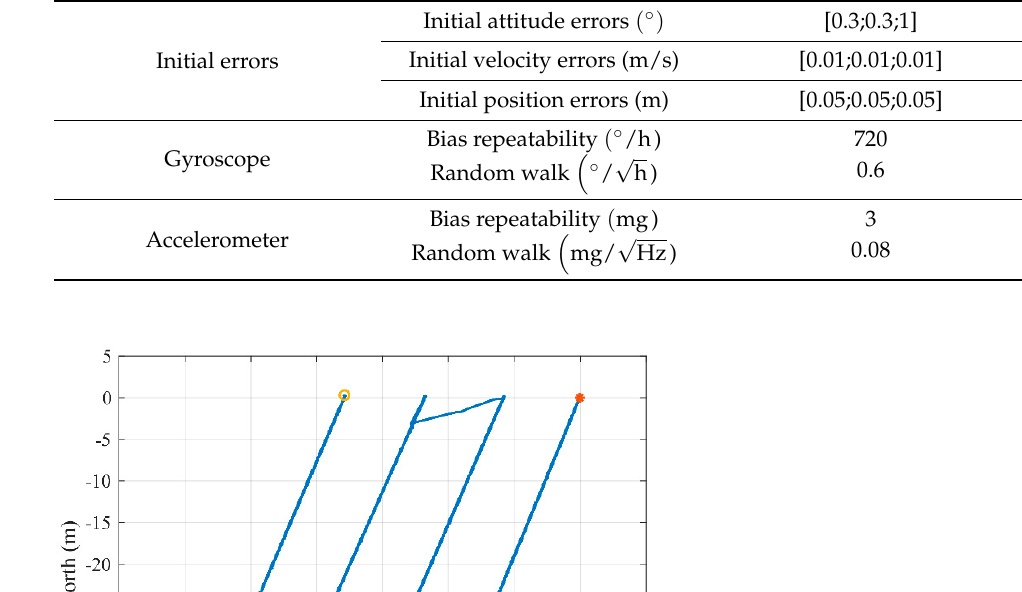
Figure 6. Trajectory of the mobile carrier during the experiment. Table 1. Specifications of the MIMU and initial errors.